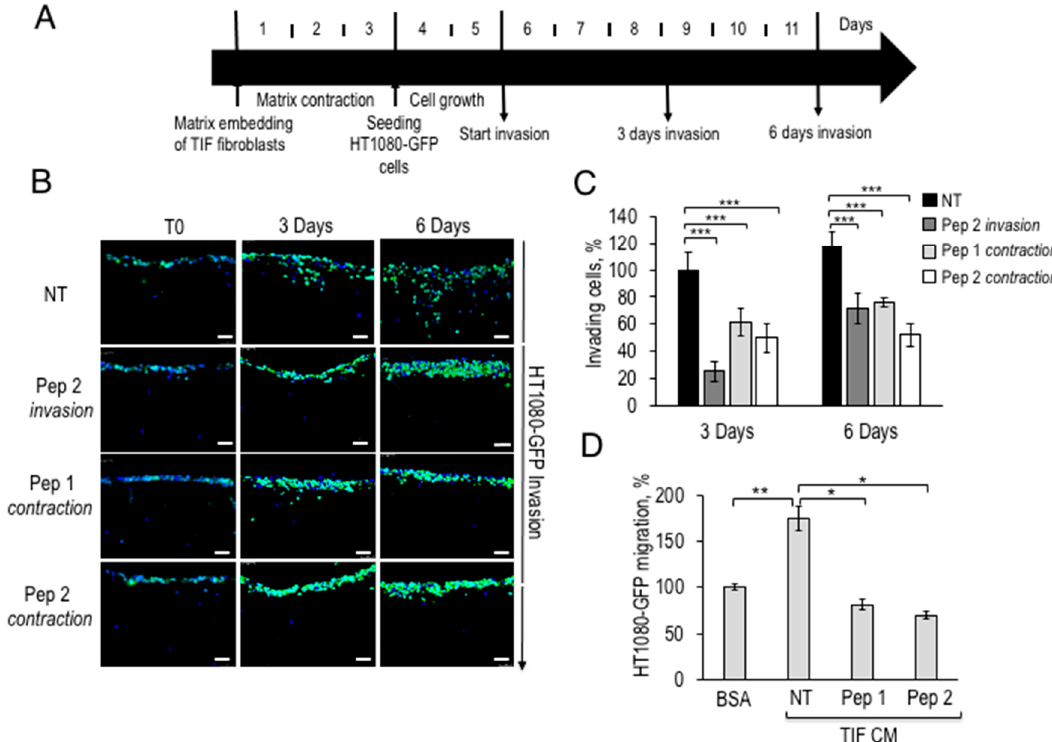
Figure 3. Fibrosarcoma cell invasion in the presence of fibroblasts pre ‐ exposed to Pep 1 or Pep 2 in 3D ‐ Organotypic assays. ( A ) Time scale representation of the 3D ‐ organotypic invasion assay. 5 × 10 4 TIF fibroblasts/sample were first embedded into a neutralized collagen I solution and incubated for 3 days. Then 1 × 10 5 HT1080 ‐ GFP cells were seeded on the matrices, grown for 2 days (T0) and let to invade for 3 or 6 days. Matrices were then processed as described in Section 4.14. ( B ) Representative images of matrices sections after DAPI staining, 20× magnification, Scale bar, 50 μ m. Fibroblasts were processed as described in ( A ), in the absence of Pep 2 (NT). Duplicate samples were exposed to 100 nM Pep 2 during HT1080 ‐ GFP invasion (Pep 2 invasion) or to 100 nM Pep 1 or Pep 2 during matrix contraction (Pep 1 contraction, Pep 2 contraction) and then peptides were removed and the matrices washed twice with growth medium. During contraction or invasion peptides were added to matrices every day. ( C ) The number of invading cells was quantified by densitometric analysis of images shown in B, with ImageJ software, the number of HT1080 ‐ GFP invading cells on untreated matrices was normalized to T0 and the 3 days sample was considered as 100%. ( D ) 5 × 10 4 TIF fibroblasts were seeded in DMEM ‐ 10% FBS in 6 well plates for 24 h, serum ‐ starved for 6 h and incubated for 24 h in presence or in the absence of 100 nM Pep 1 or Pep 2 peptides in DMEM ‐ 10%FBS. Peptides were then removed and, after two PBS 1× washes, cells were incubated in serum ‐ free medium for 24 h. Conditioned media (CM) from TIFs exposed to Pep 1 or Pep 2 were collected and employed as a chemoattractants for H1080 ‐ GFP cells in Boyden chamber migration assays. In each sample, 2 × 10 4 HT1080 ‐ GFP cells were tested either toward DMEM ‐ 0.1% BSA (basal migration) or toward TIFs CM. Basal migration was taken as 100% and all values were calculated relative to that. * p < 0.05; ** p < 0.005; *** p < 0.001, Student’s t ‐ test.